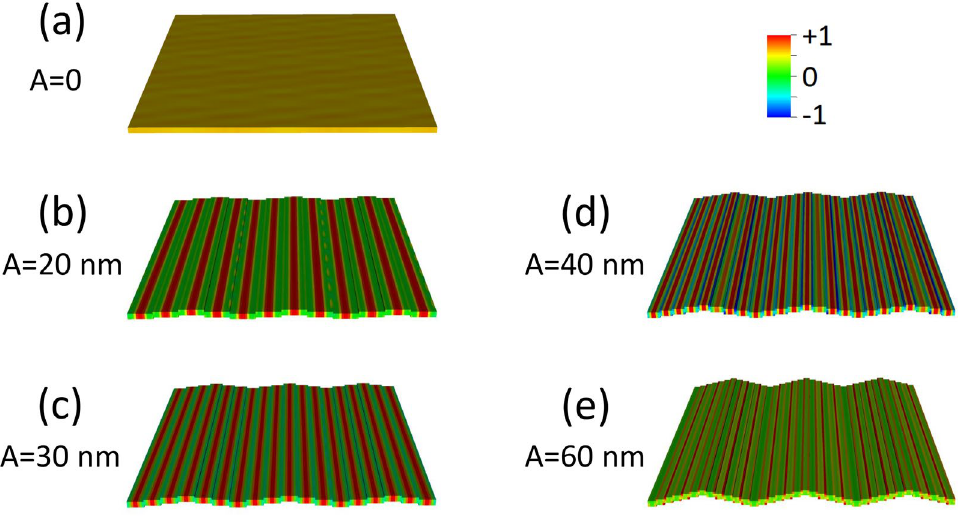
Figure 7. Real part of the out-of-plane (z) dynamic magnetization phase profile (in arbitrary units) for k = 0, in configuration M (cid:31) x , for increasing undulation amplitude, shown in perspective to highlight the involvement of the third dimension. (a) Planar film; (b) 4-layer system; (c) 6-layer system; (d) 8-layer system; (e) 12-layer system. The strong dipolar fields, arising because the stripe elements are magnetized along the finite width of the elemental stripes, are at the origin of the localization of the dynamic magnetization at the center of each stripe. In (e) , the stripe width is so small (60 nm) that no bulk-like solution is possible even in the single elemental stripe, and the most uniform mode shows nonzero amplitude only at the edges of each elemental stripe: this profile Is qualitatively different from the others. Note that each map is a 3 × 3 repetition of the primitive cell, as an indicative extract of the ideally infinite system.